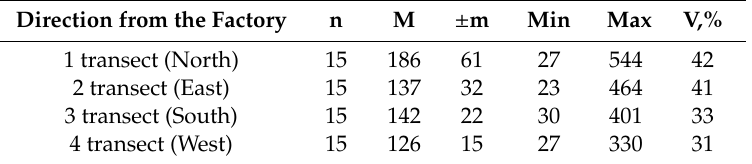
Table 7. Statistical parameters of the magnetic susceptibility of the upper soil horizons (0–10 cm) of the